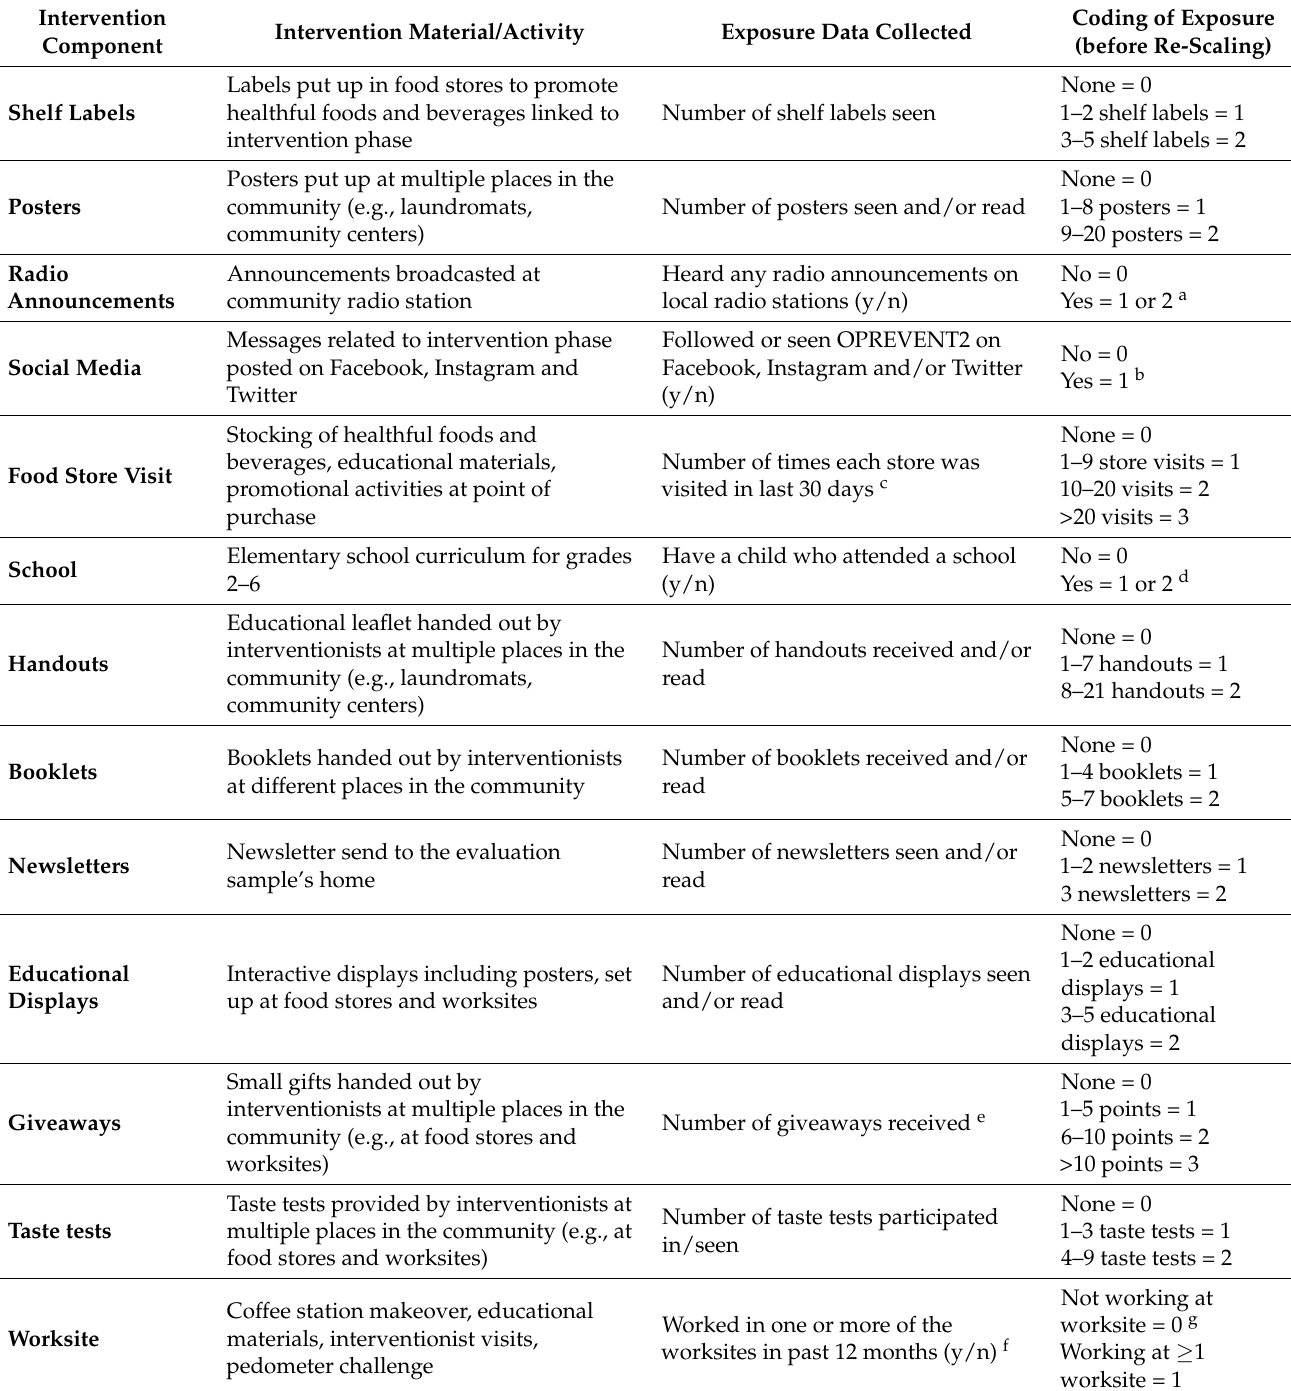
Table 1. Exposure scores for OPREVENT2 intervention materials and